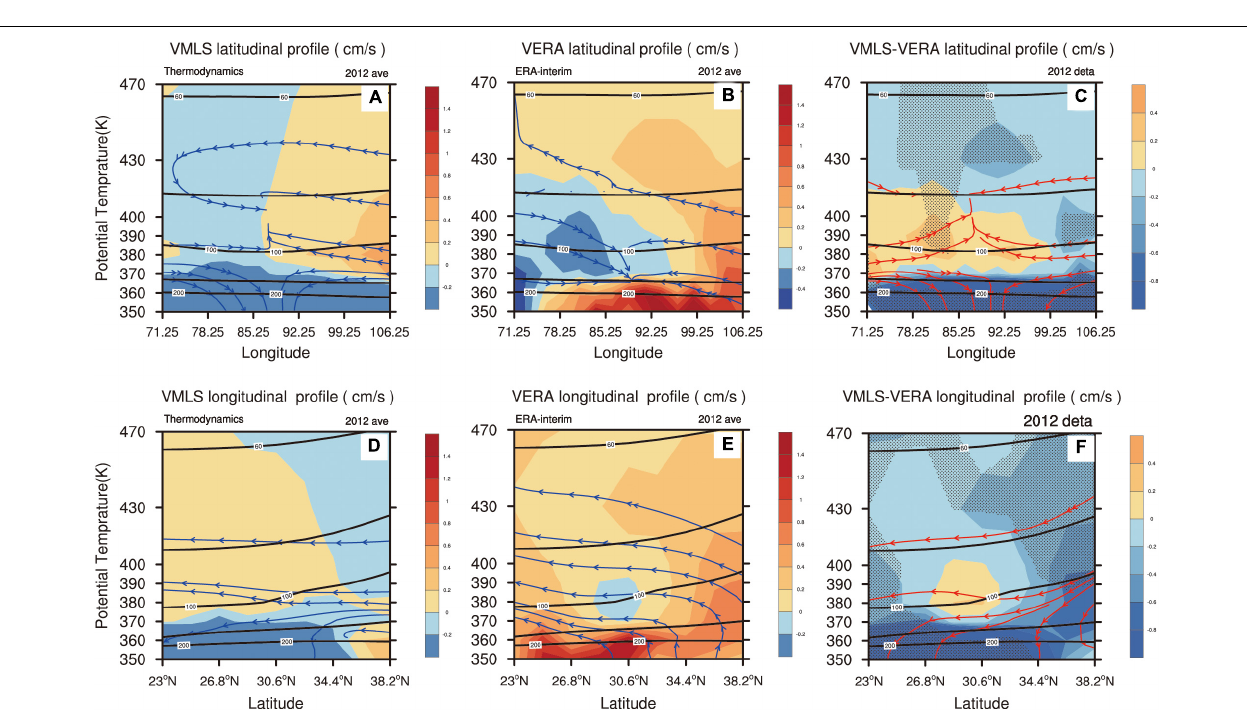
Frontiers in Earth Science |